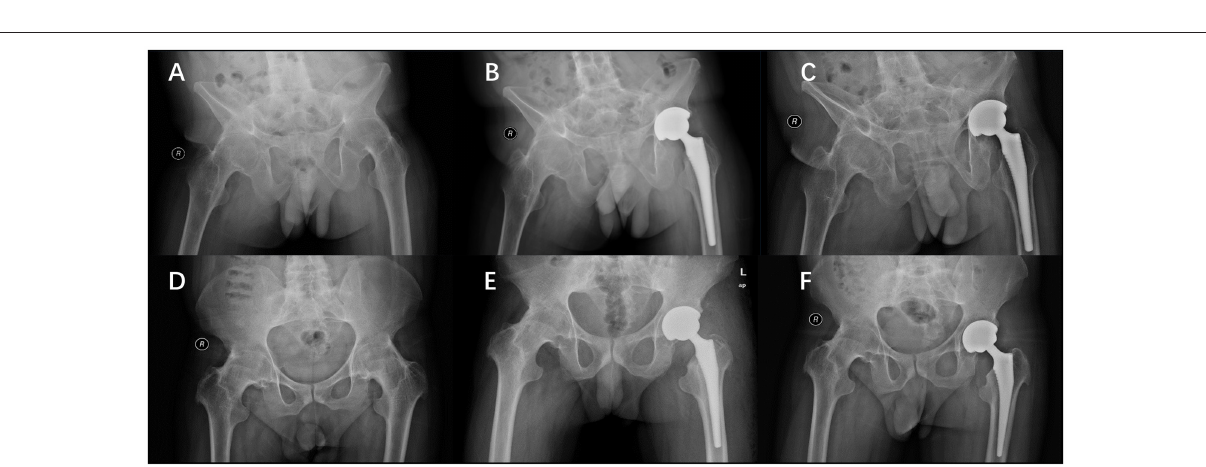
FIGURE 5 | Conversion of extended hip fusion to DAA-THA in a 30-year-old male. Preoperative (A) , 1 month (B) and 1 year postoperative (C) radiographs. Conversion of flexural hip fusion to DAA-THA in a 33-year-old male. Preoperative (D) , 1 month (E) and 1 year postoperative (F)